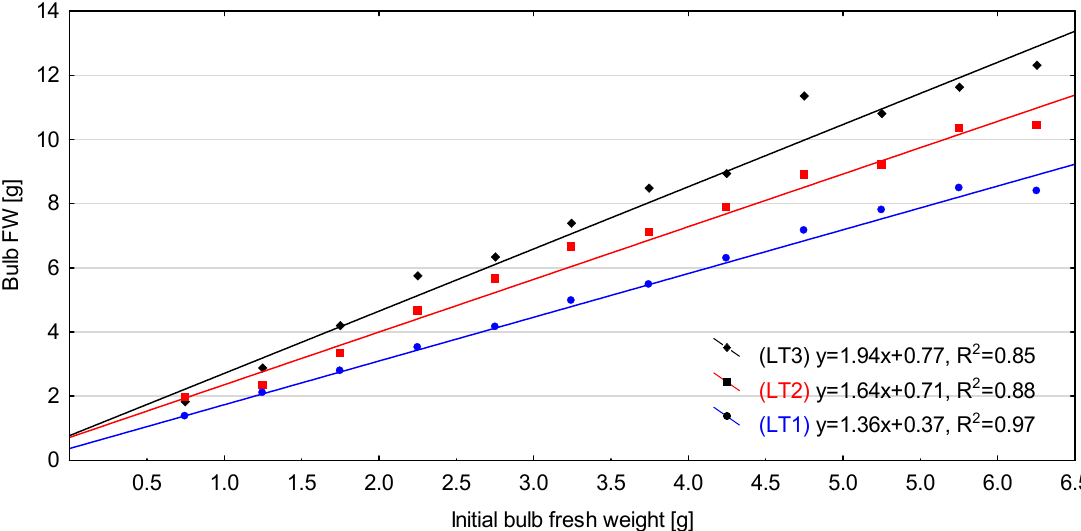
Figure 12. Linear regression analysis of the bulb initial fresh weight and post-harvest fresh weight (bulb FW) under different lifting term (LT1–LT3) conditions.